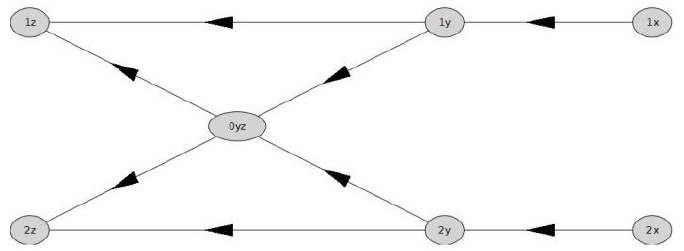
Figure 12. Graphical representation of the second attempt to codify a scissors crossing.